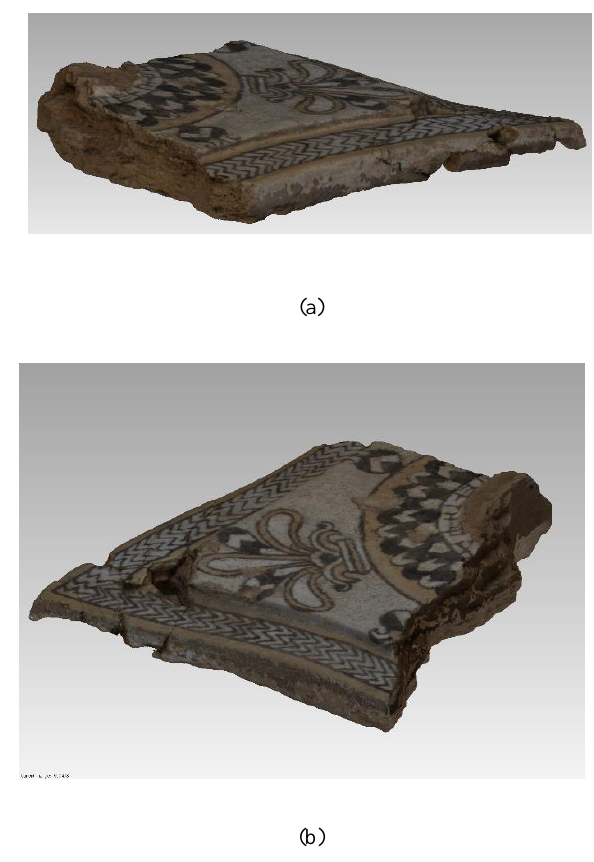
Figure 16. (a,b) The 3D model of the gazed knobbed tile (one million